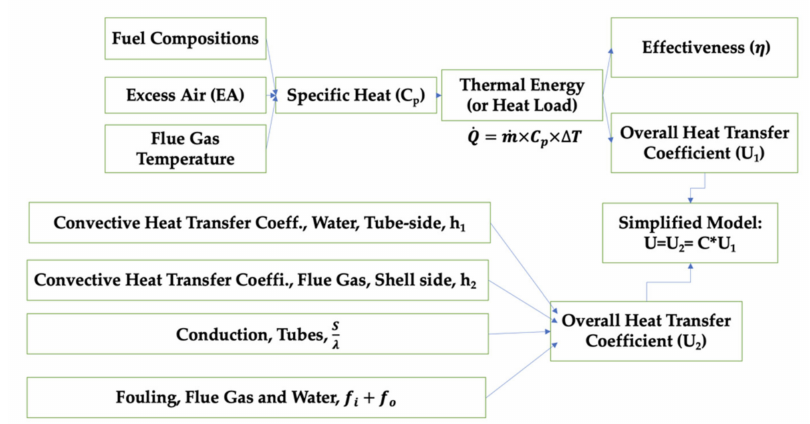
Figure 1. Approach to estimate specific heat and overall heat transfer